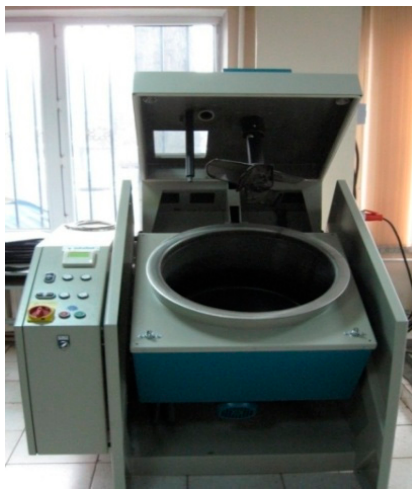
Figure 3. Laboratory mixing device for preparing of asphalt concrete mixes.